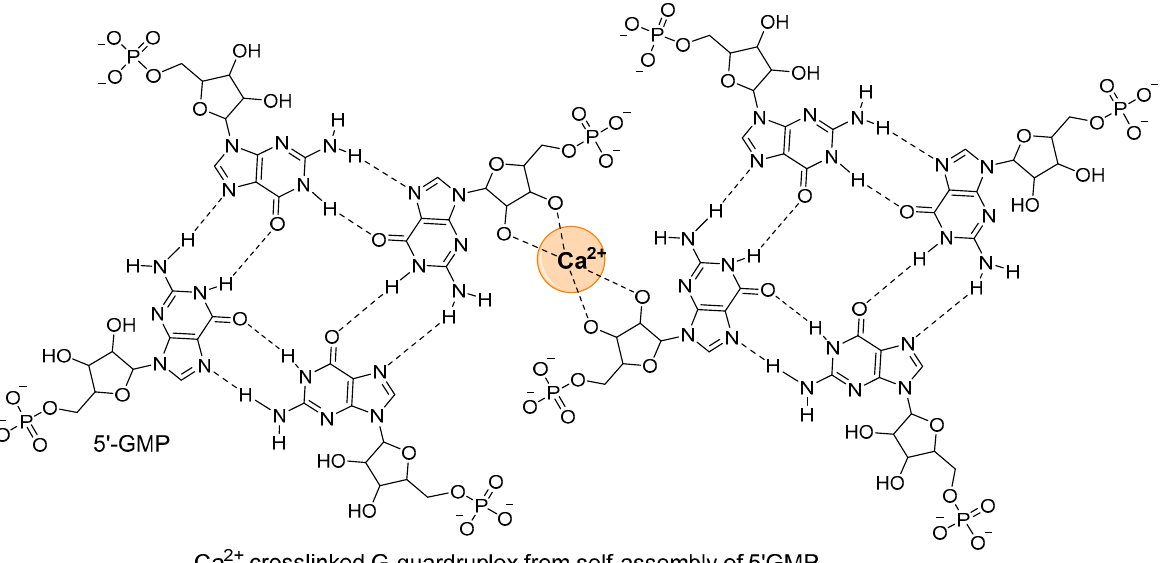
Figure 48. Guanosine monophosphate and the self-assembled G-quadruplex with Ca 2+ [97].